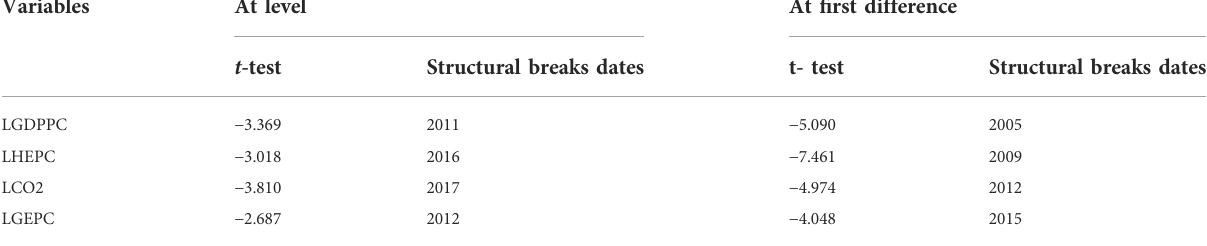
TABLE 3 Zivot- Andrews Unit Root